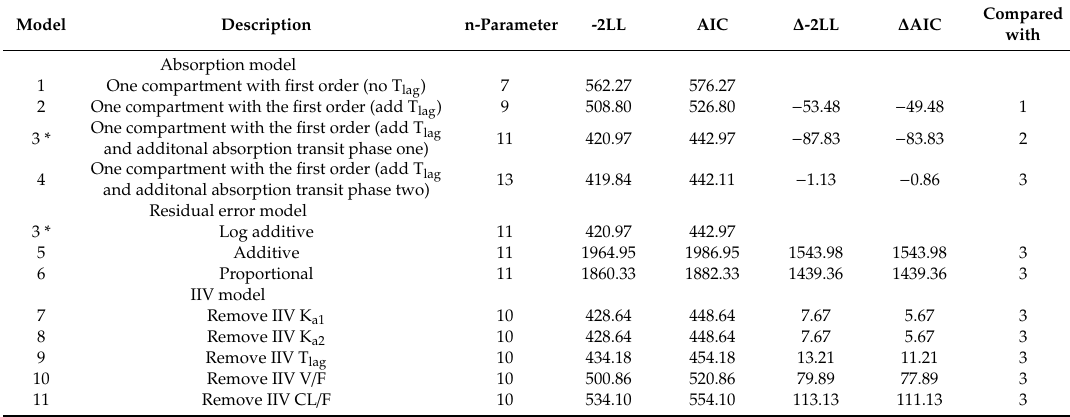
Table 4. Basic structural model building steps.